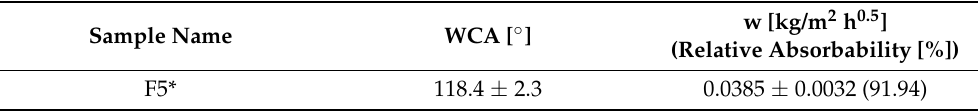
Table 5. The concrete with neutral 5% OPTES treatment: water contact angle (WCA) values and relative water permeability (w) after 24 h of immersion.